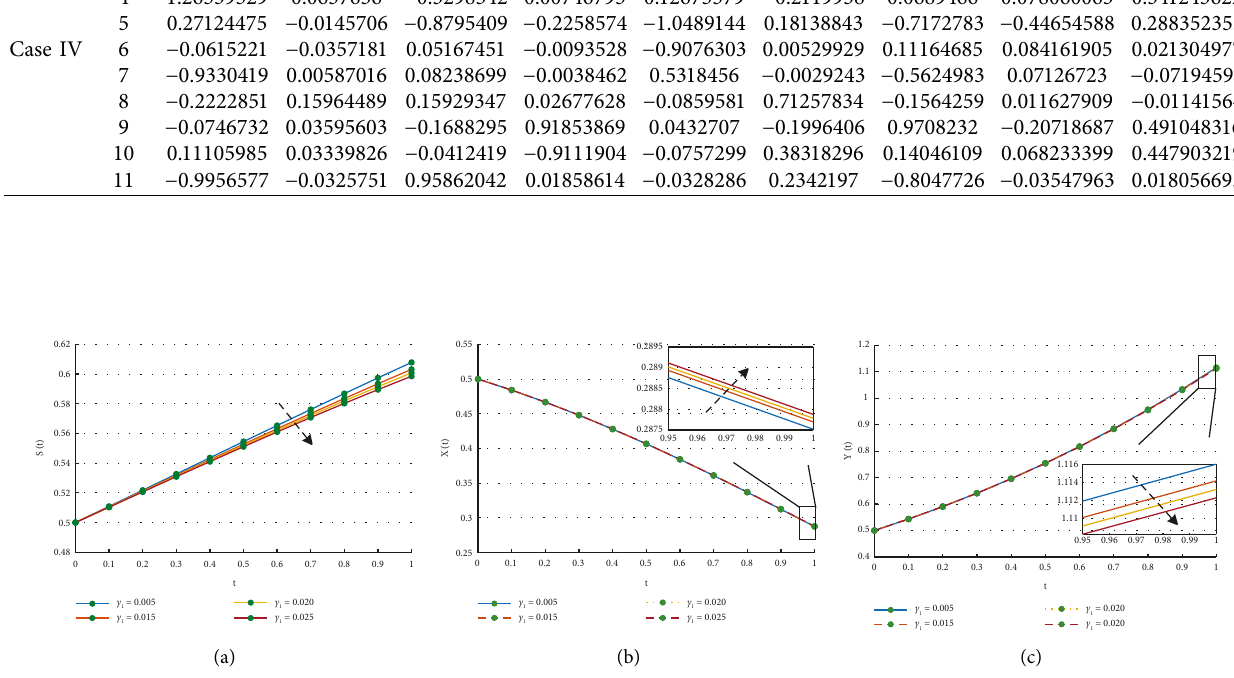
Table 39: Comparison between solutions obtained by the LeNN-WOA-NM algorithm and ode45 for the prey-predator model with c t S ( t ) ode 45 X ( t ) ode 45 Y ( t ) ode 45 0.0